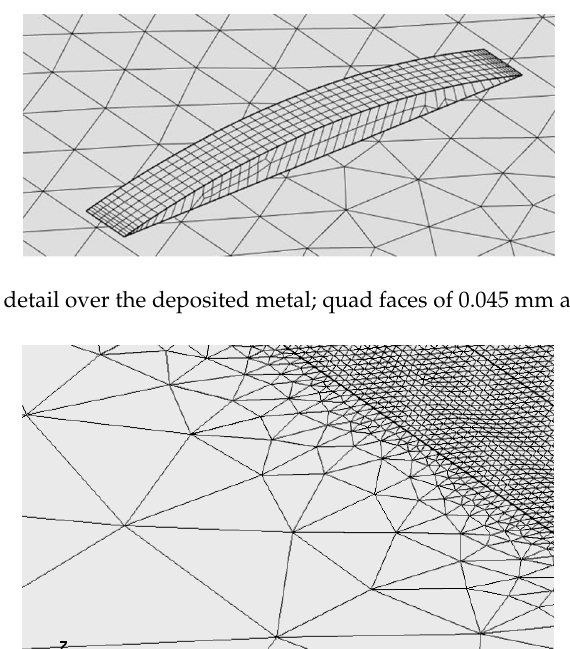
Figure 16. Domains of interest: deposited metal (red, D 1 ), central slot (yellow, D 2 ), remaining parent metal (grey, D 3 ) and side slices for mechanical constraints (blue, D 4 ); point of interest P to monitor the resulting strain of the part.